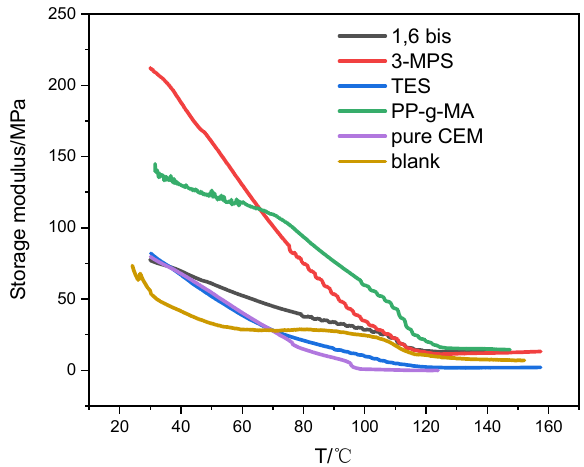
Figure 6. Storage–temperature relationship of the composite with different coupling agents treated GF.